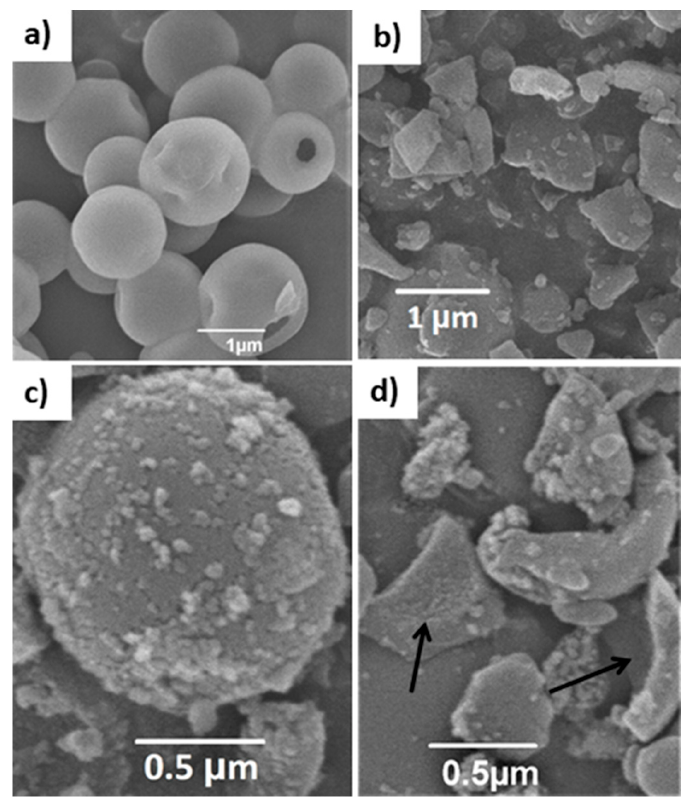
Figure 1. ( a ) SEM images of the hollow spheric material 1 , ( b ) nanosheets of the final catalyst 2 , ( c ) outer surface of catalyst 2 after the labelling experiment and ( d ) the inner surface of catalyst 2 after the labelling